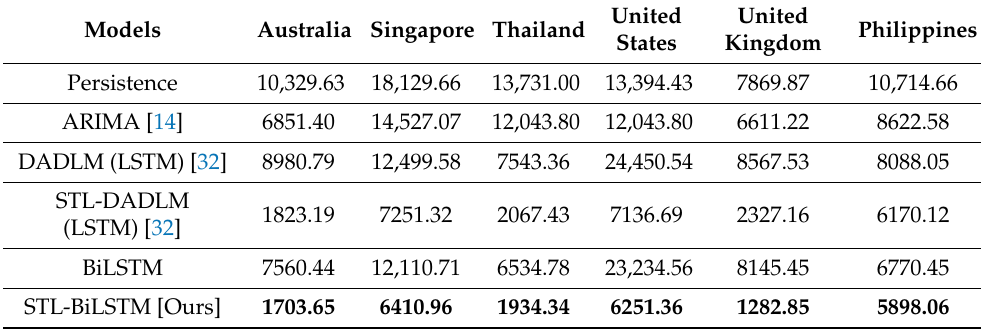
Table 4. MAE comparison for selected forecasting methods for six source